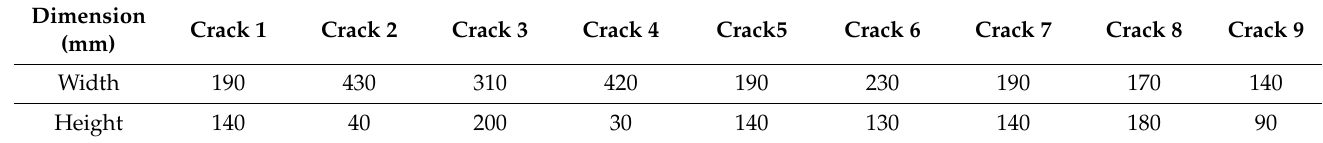
Table 2. The physical dimensions of cracks in our customized